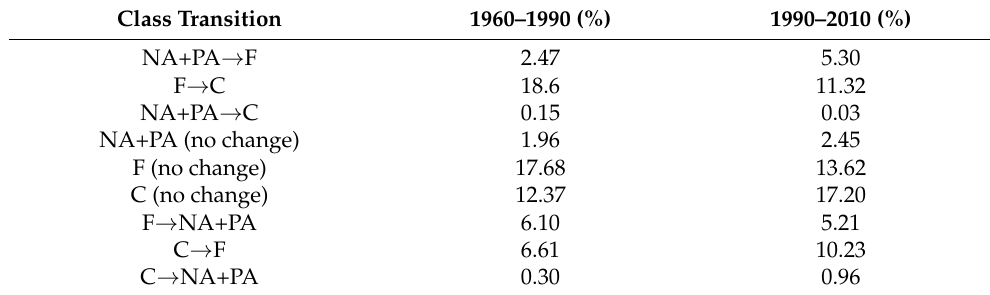
Table 4. Land vulnerability trajectories (per cent share in total landscape) in Italy by time interval.